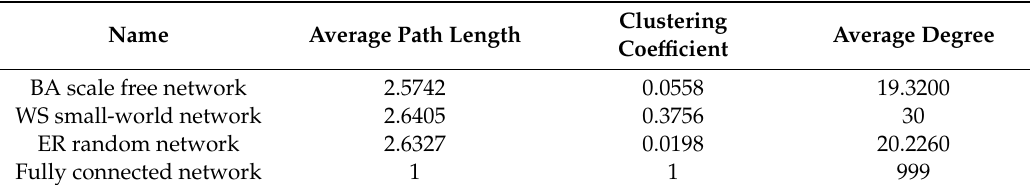
Table 3. Di ff erent network topology parameters.